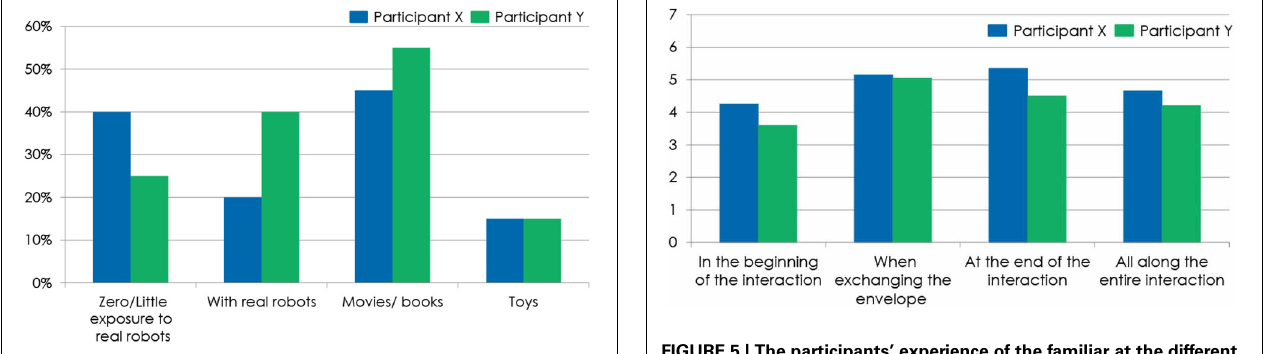
FIGURE 3 | The participants’ earlier exposure to robots and source of exposure: movies and/or books, toys, real robots or no/little exposure.